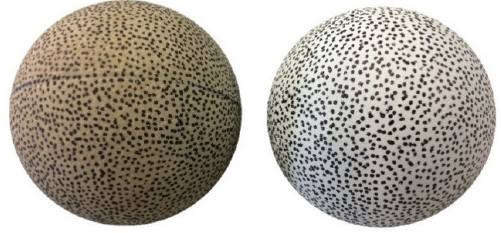
Figure 2. Ball preparation. Left: pressurised ball core; Right: pressureless ball core.